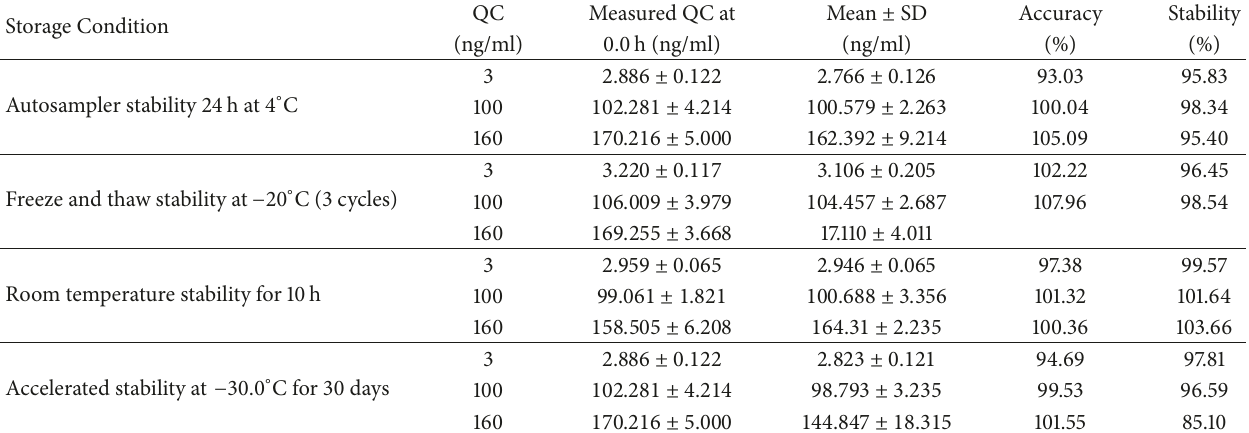
Table 4: Stability of enalapril under different storage conditions ( 𝑛 = 6 ).